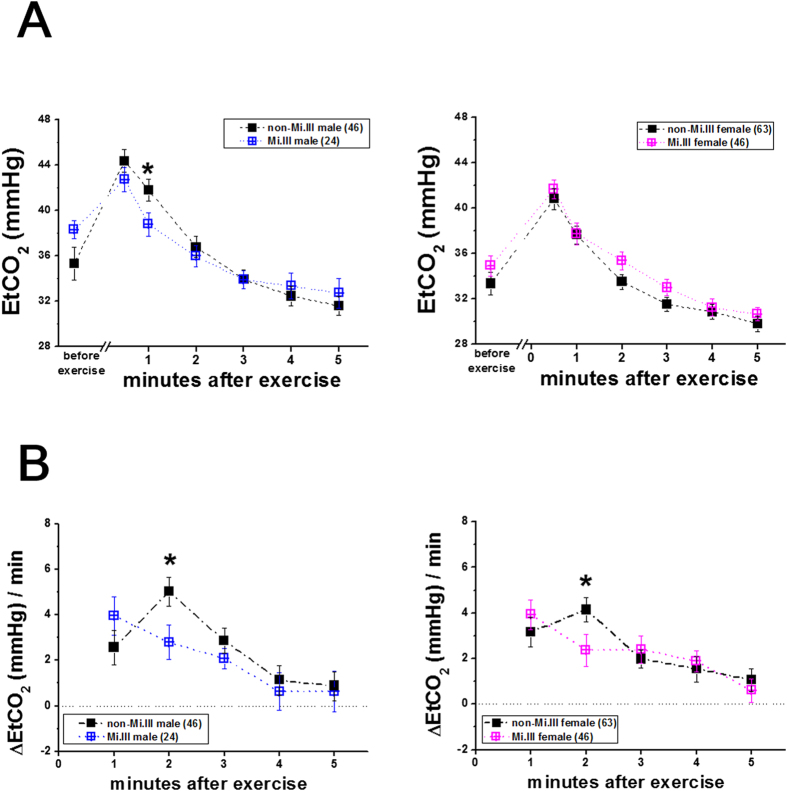
CO2 clearance immediately following exercise were faster for Mi.III+subjects than for subjects lacking Mi.III expression.Left: EtCO2 measurements in male participants; right: in female participants. (A) EtCO2 measurements for Mi.III (blue or pink color) and non-Mi.III (black). (B) Minute-to-minute changes of CO2 expiration (ΔEtCO2/min) were compared between Mi.III (blue/pink) and non-Mi.III (black). CO2 expiration in non-Mi.III participants remained substantial at the 2nd minute following the step test, but had subdued in Mi.III+participants by the 2nd minute (*p < 0.05). The numbers of the test subjects are indicated in parentheses. Shown mean ± SEM.